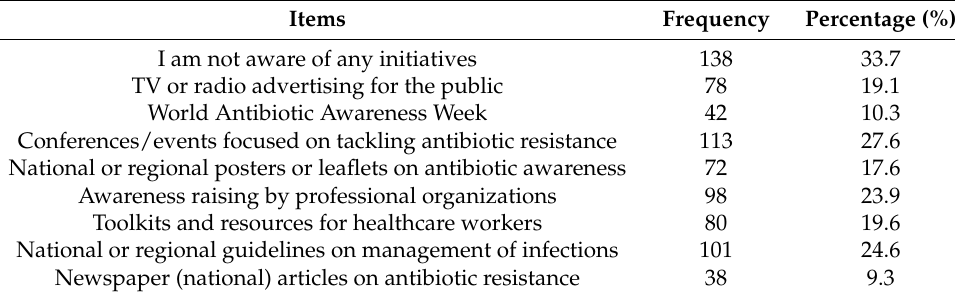
Table 4. Awareness of initiatives on antibiotic awareness and resistance.